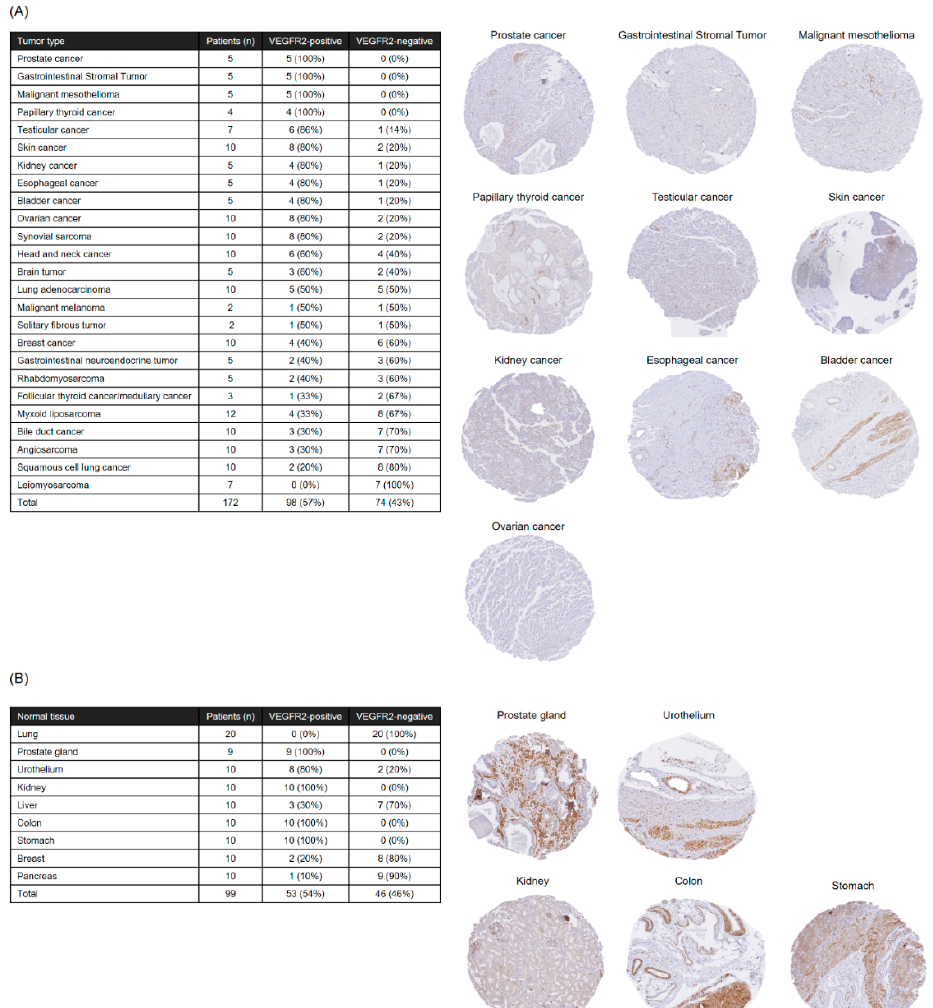
Figure 5. Analysis of VEGFR2 expression in formalin-fixed, paraffin-embedded specimens of various solid tumors ( A ) or normal tissues ( B ) using immunohistochemistry and the 55B11 antibody. The table summarizes the results of immunohistochemistry staining for each cancer type or normal tissue; tissues with a high frequency of VEGFR2 expression are shown as representative images.